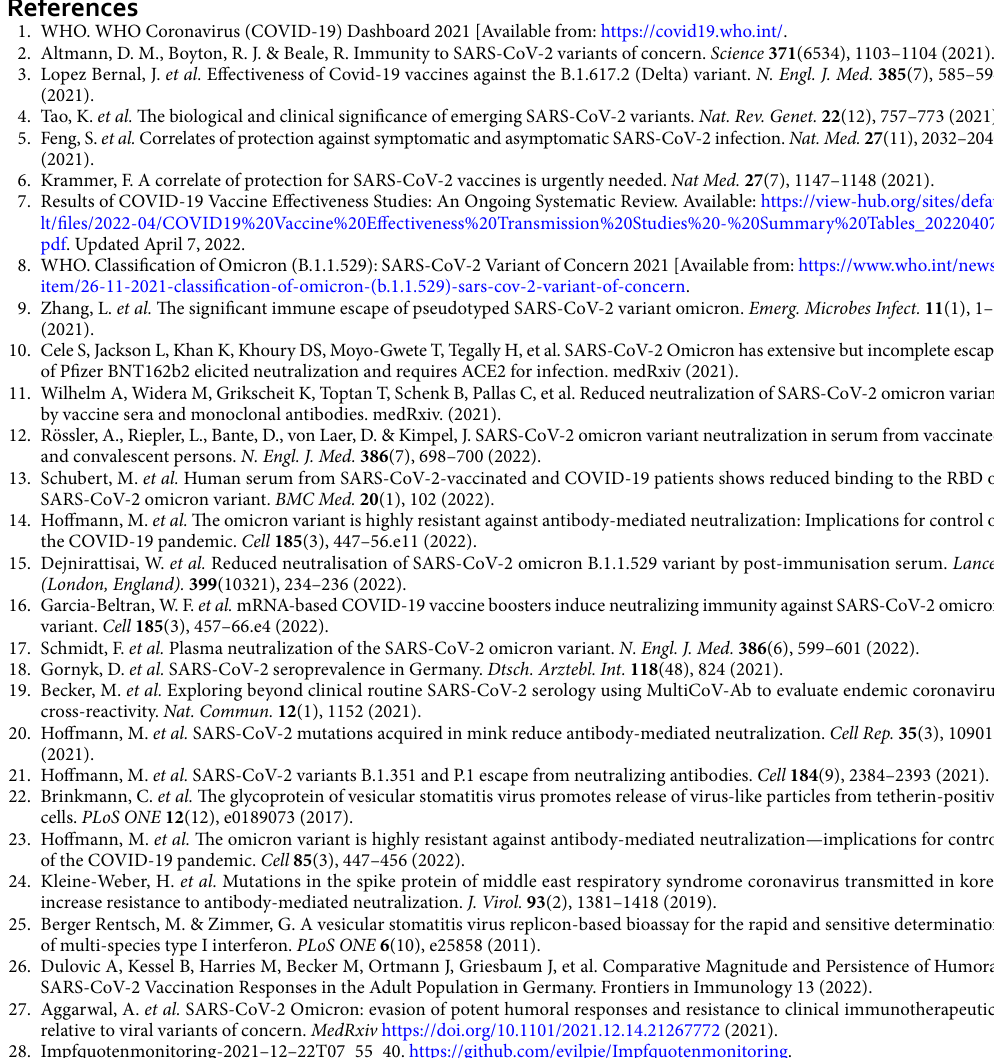
Figure 2. Longitudinal BNT162b2 neutralization response towards SARS-CoV-2 VoC Omicron sub-lineage BA.1. Neutralization capacity towards SARS-CoV-2 Omicron (BA.1), Beta (B.1.351), Delta (B.1.617.2) or Wuhan (B.1) pseudotypes was analyzed approximately six months after a two-dose BNT162b2 vaccination (n = 23), ( a ). Neutralization kinetic of paired longitudinal samples towards SARS-CoV-2 B.1 ( b ), Beta ( c ), Delta ( d ) and Omicron BA.1 ( e ) pseudotypes is shown between T1 (n = 23; mean (SD) ΔT after last dose: 29.5 (7.3)) and T2 (n = 23; mean (SD) ΔT after last dose: 174.0 (14.2)). Peak neutralization responses of BNT162b2-vaccinated individuals from Fig. 1c are displayed again for clarity and comparison (b-e). FRNT 50 data is expressed for each serum sample, bold horizontal lines and whiskers are geometric means with 95% CI. Interconnecting lines represent sample data from the same donor ( a – e ). Non-neutralizing samples were arbitrarily set to 1 for presentation purposes, indicated by a dashed line. Fold-change in neutralization potency between SARS-CoV-2 B.1 and VoC pseudotypes is shown below p -values. Percentage (%) responder rates and FRNT 50 geometric mean titers (GMT) per SARS-CoV-2 pseudotype are shown above the individual measurements. Fold change in neutralization potency and GMTs for SARS-CoV-2 pseudotypes are only calculated for groups where all samples had a detectable neutralizing activity, or else not applicable (na) is stated. Statistical analysis was performed by paired non-parametric Friedman’s test followed by a Dunn’s multiple comparison analysis ( a ) or a by two-tailed Wilcoxon matched-pairs signed rank test ( b – e ). Statistical significance was defined by a value of * < 0.05; ** < 0.01; *** < 0.001; **** <